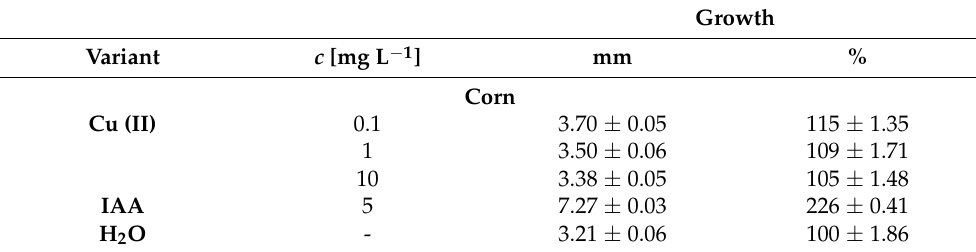
Table 2. Influence of Cu(II) complex solutions of different concentrations ( c ) on the growth of coleoptile segments (mm) in 24 h ( n = 45) *. Water was used as a control and indole-3-acetic acid (IAA) as a standard.